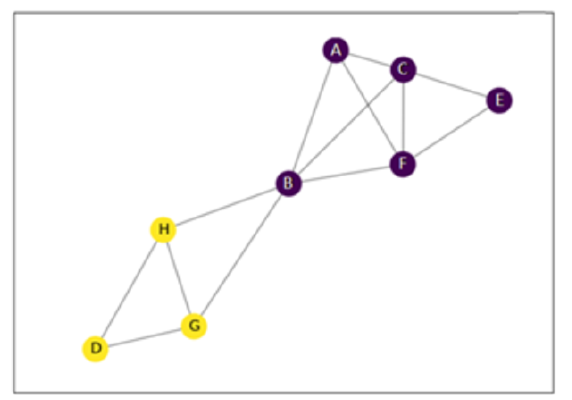
Figure 1. Example of a graph with